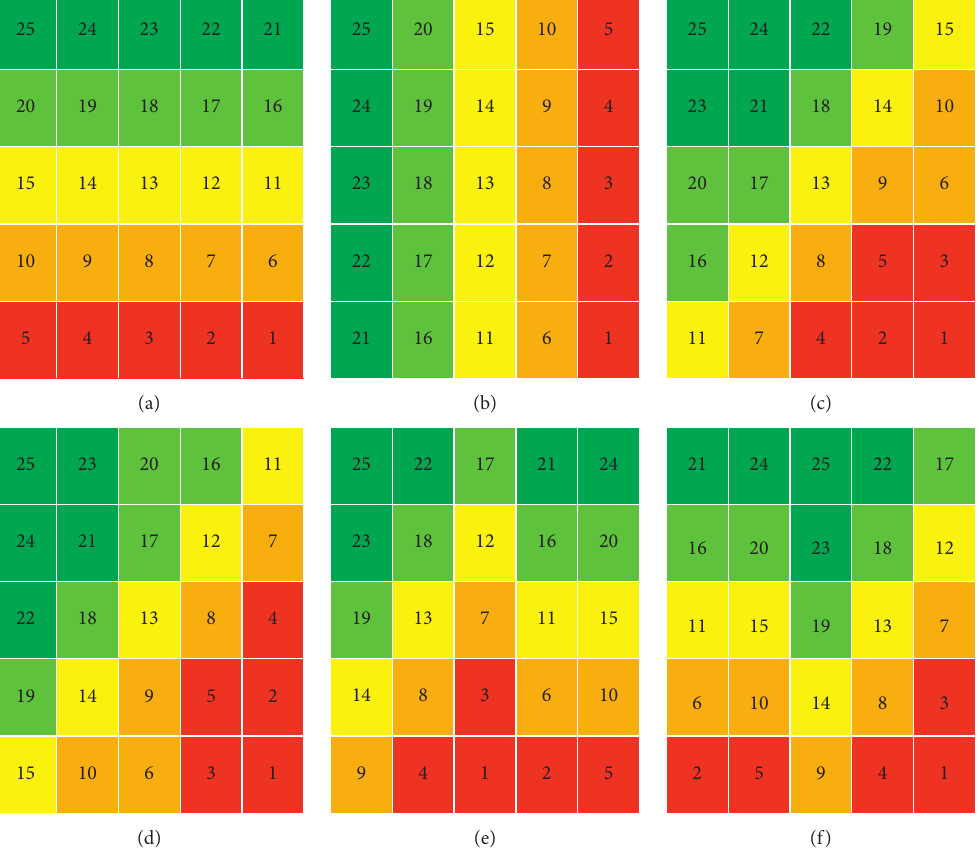
Figure 3: Mining sequence schemes 1–6. (a) Scheme 1. (b) Scheme 2. (c) Scheme 3. (d) Scheme 4. (e) Scheme 5. (f) Scheme 6. Table 1: Mechanical parameters of the rock mass and backfill. Rock